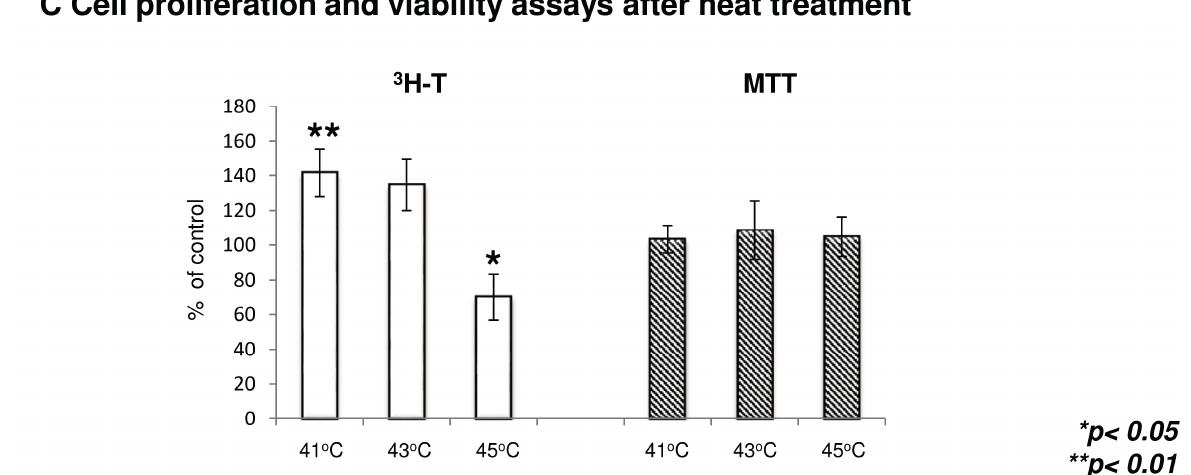
Figure 4. The effect of heat treatment on cartilage matrix production, chondrogenic marker gene expression and cellular proliferation. ( A ) Metachromatic cartilage matrix in micromass cultures after applying different heat stimuli (41, 43 and 45 °C for 30 min). Metachromatic cartilage areas in six-day-old cultures were visualised with DMMB dissolved in 3% acetic acid. Representative photomicrographs of 13 independent experiments are shown. Original magnification was 2×. Scale bar, 1 mm. Optical density (OD 625 ) was determined in samples containing TB extracted with 8% HCl dissolved in absolute ethanol. Data are expressed as mean ± SEM. Asterisks represent significant difference compared to control cultures ( * p < 0.05). Data shown are the average of 13 independent experiments; ( B ) Conventional RT-PCR analysis of chondrogenic markers genes (ACAN; aggrecan core protein, Sox9, and COL2a1; collagen type II). Chicken micromass cultures were exposed to 41, 43